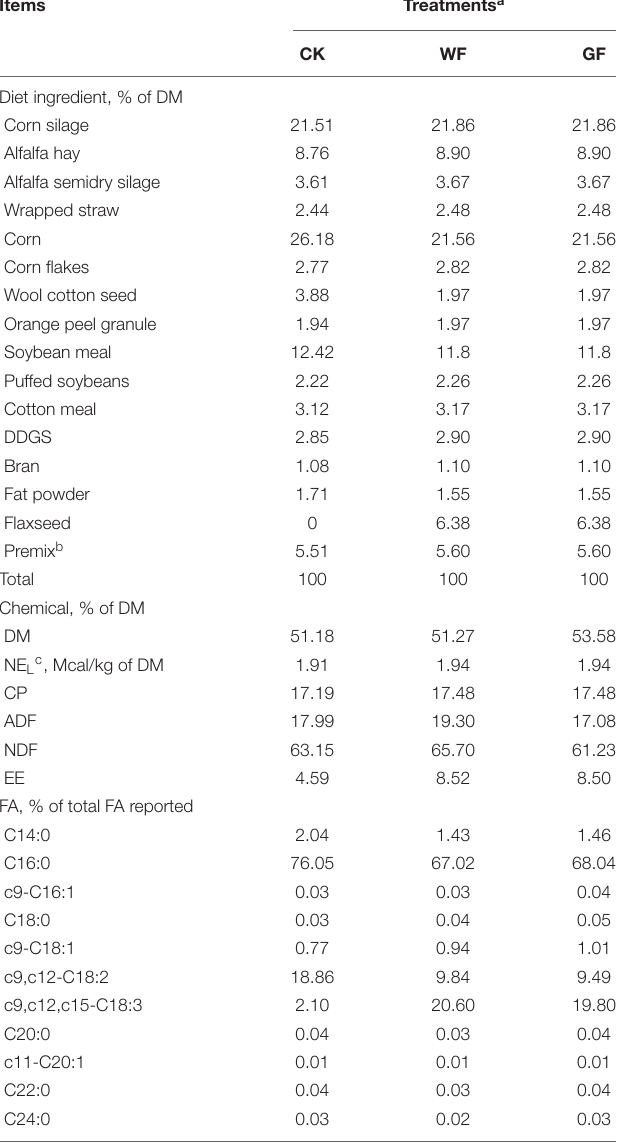
TABLE 1 | Composition of experimental diets (% DM